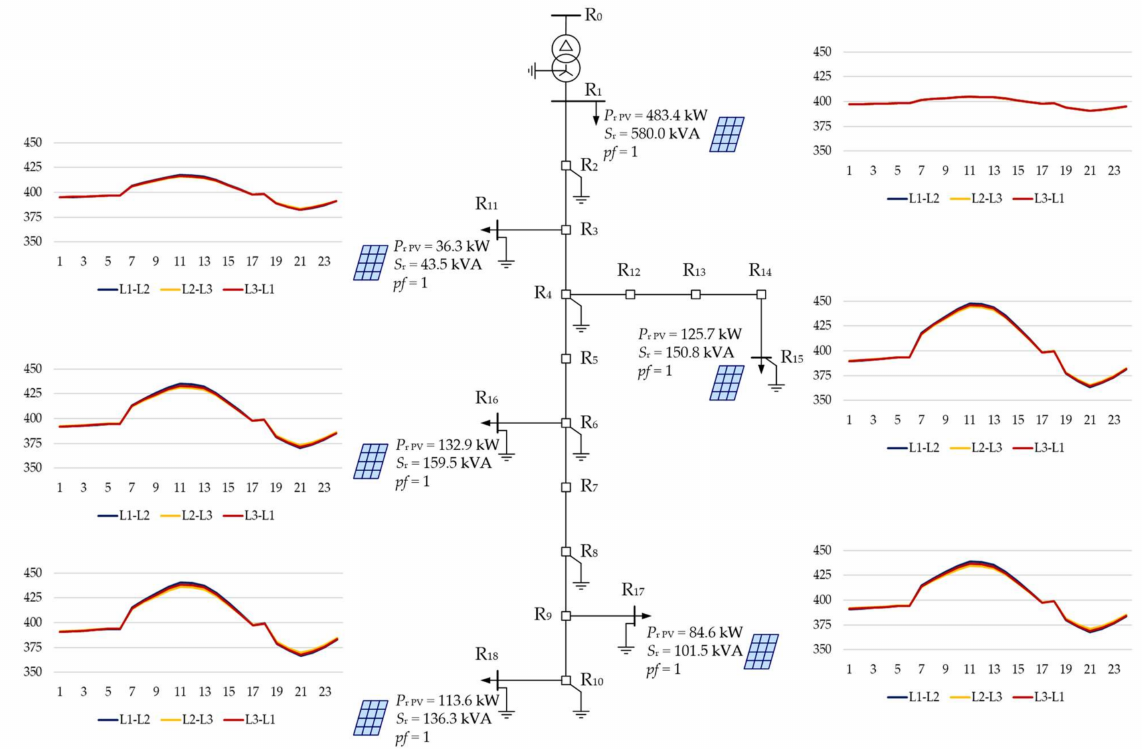
Figure 16. Daily simulation results showing the phase-to-phase voltages (V) in the test network for variant